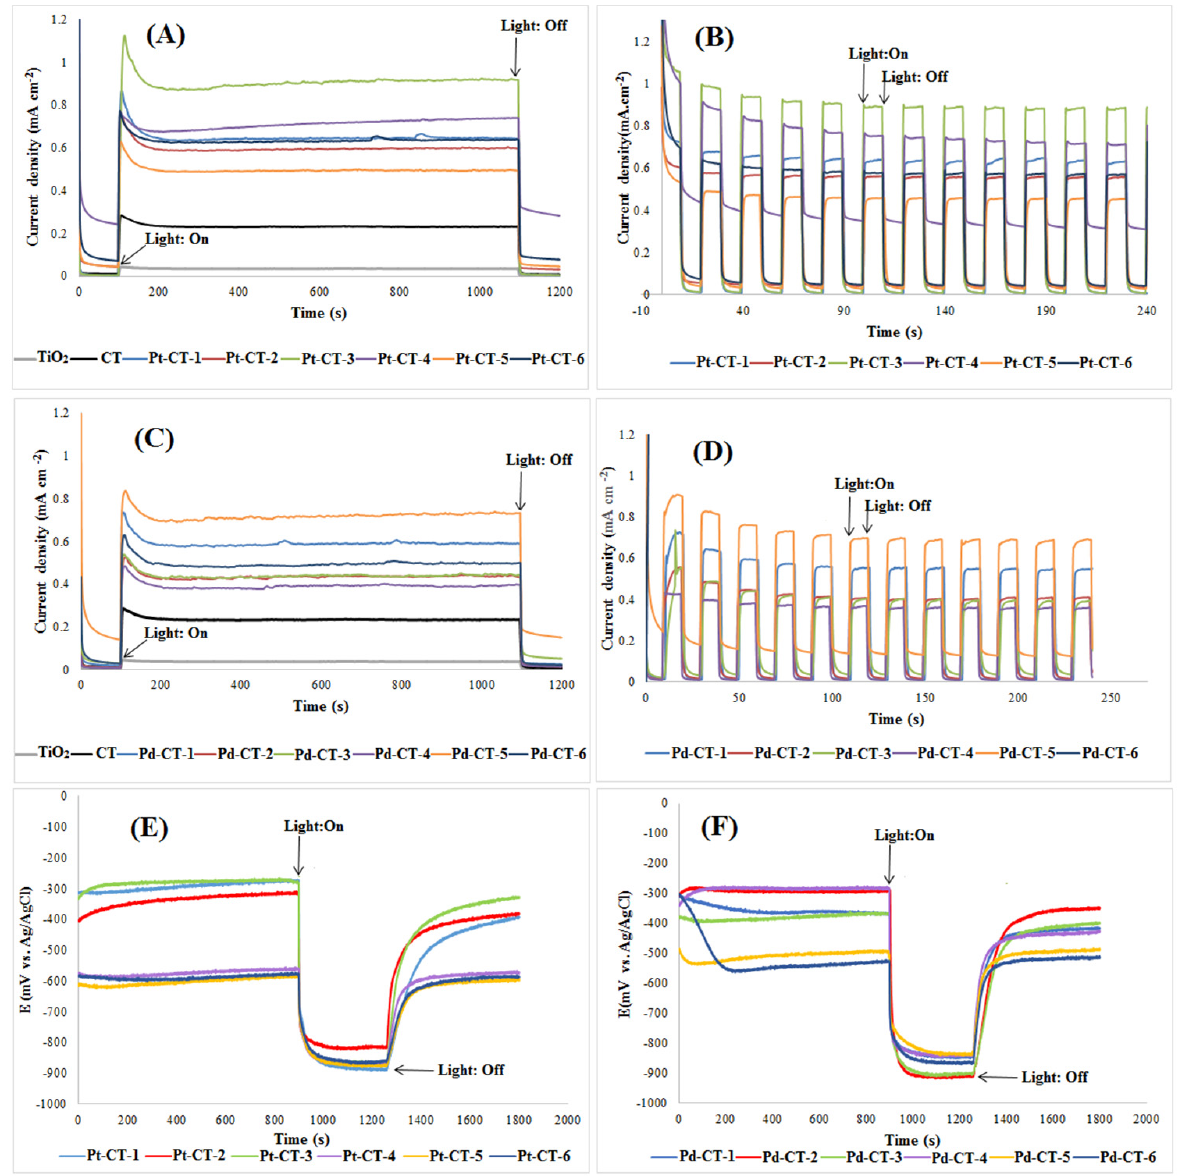
Figure 5. Photocurrent responses of Pt-CT ( A , B ), and Pd-CT electrodes ( C , D ) for long time (1200 s) and under chopping light (Xe lamp), at a potential of 0.6 V vs. Ag/AgCl, OCP curves of Pt-CT ( E ) and Pd-CT ( F ) samples in solution of KOH (1 M) with 5 vol% EG.